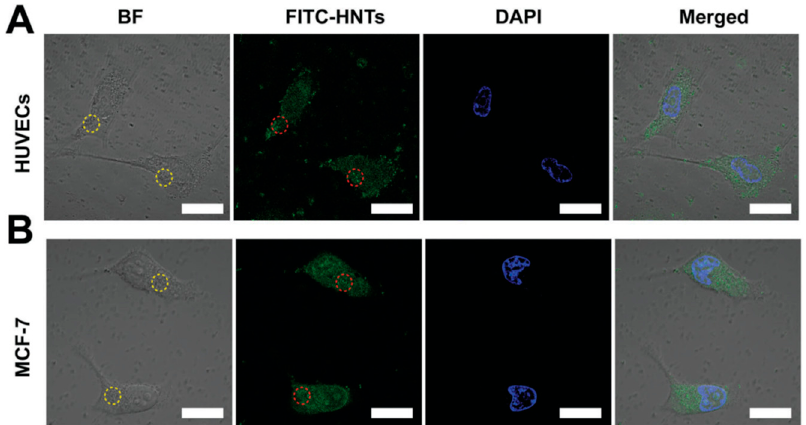
Figure 5. CLSM images of ( A ) HUVECs and ( B ) MCF-7 cells. Cells incubated with FITC-HNTs (50 mg mL − 1 ); FITC-HNTs and cell nucleus are indicated in green and blue, respectively. The circles in the images represent the FITC-HNT aggregates. Scale bar = 20 mm. Adapted from [89]. Halloysite nanotube toxicity was further evaluated against human peripheral lympho- cytes by means of mitotic index assay. Different concentrations of HNTs (10, 100, 500, and 1000 µ g/mL) were incubated with the peripheral lymphocyte culture. The mitotic in-